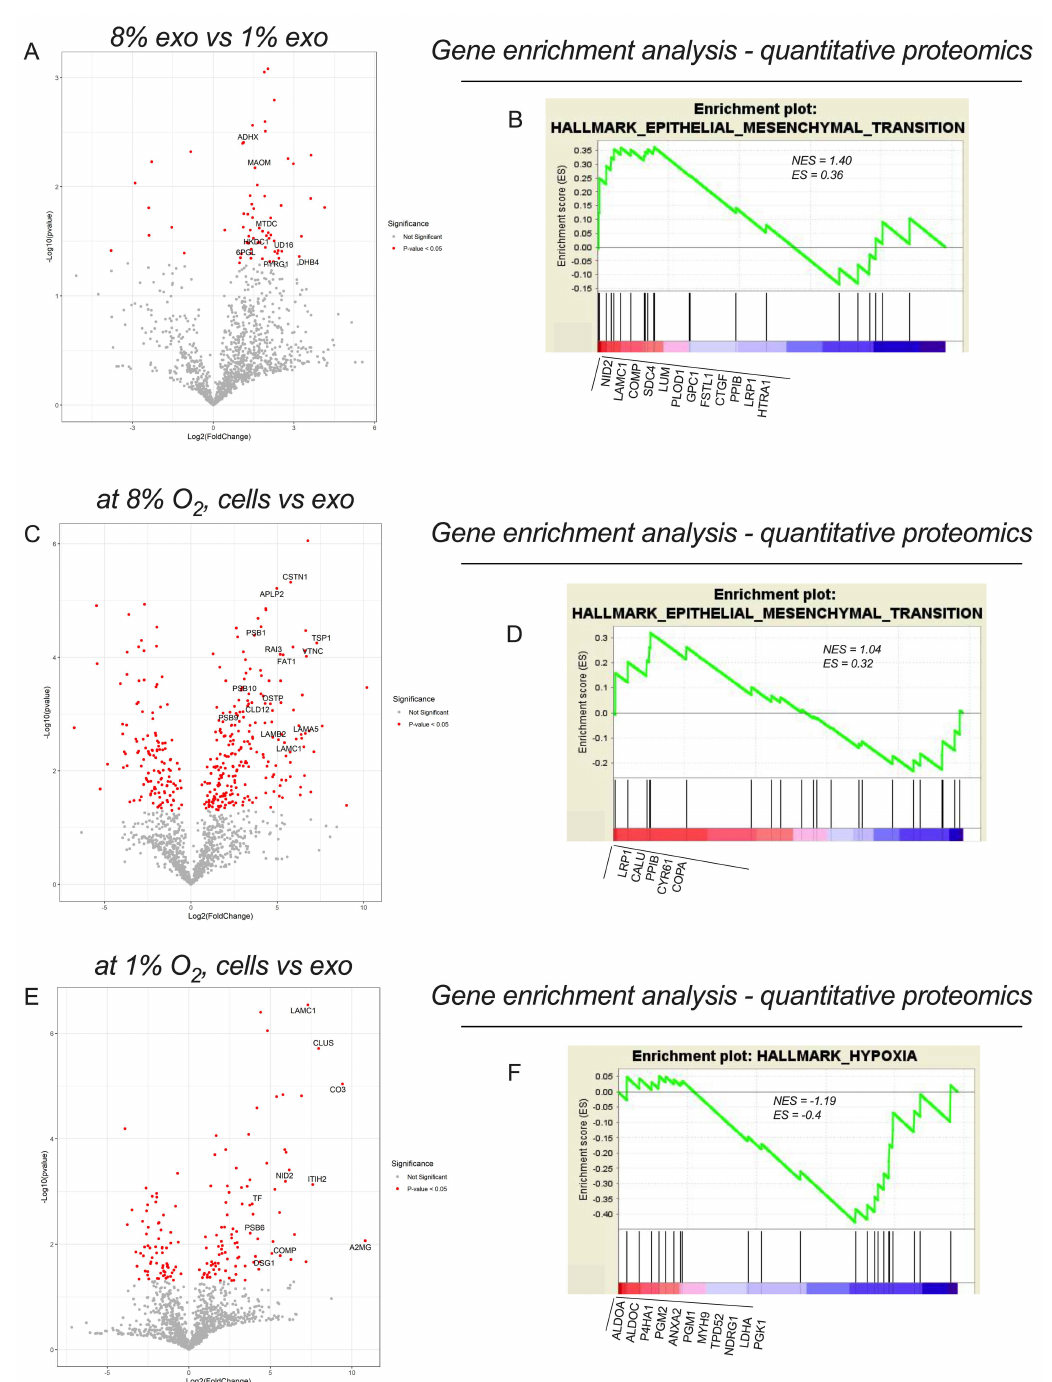
Figure 4. Proteomic analysis of CAOV-3 cells and their derived sEVs under 1% and 8% oxygen tension. ( A ) Volcano plot of proteins differentially expressed between sEVs secreted by the 8% O 2 CAOV-3 cells and the 1% O 2 CAOV-3 cells. ( B ). Volcano plot of proteins differentially expressed between the 8% O 2 CAOV-3 cells and their derived sEVs. ( C ) Volcano plot of proteins differentially expressed between the 1% O 2 CAOV-3 cells and their derived sEVs. ( D – F ) Identification of the top candidate protein using gene set enrichment analysis (GSEA) in the 1% O 2 CAOV-3 derived sEVs compared with the 8% O 2 CAOV-3 derived sEVs. The GSEA plots of proteomic data illustrate four gene clusters that are enriched in the 1% O 2 CAOV-3 derived sEVs involving: ( D ) glycolysis ( E ) the epithelial–mesenchymal transition, ( F ) hypoxia. The two top networks identified using ingenuity pathway analysis are canonical pathways and diseases and biological functions analysis for 1% O 2 sEVs in compared with 8%